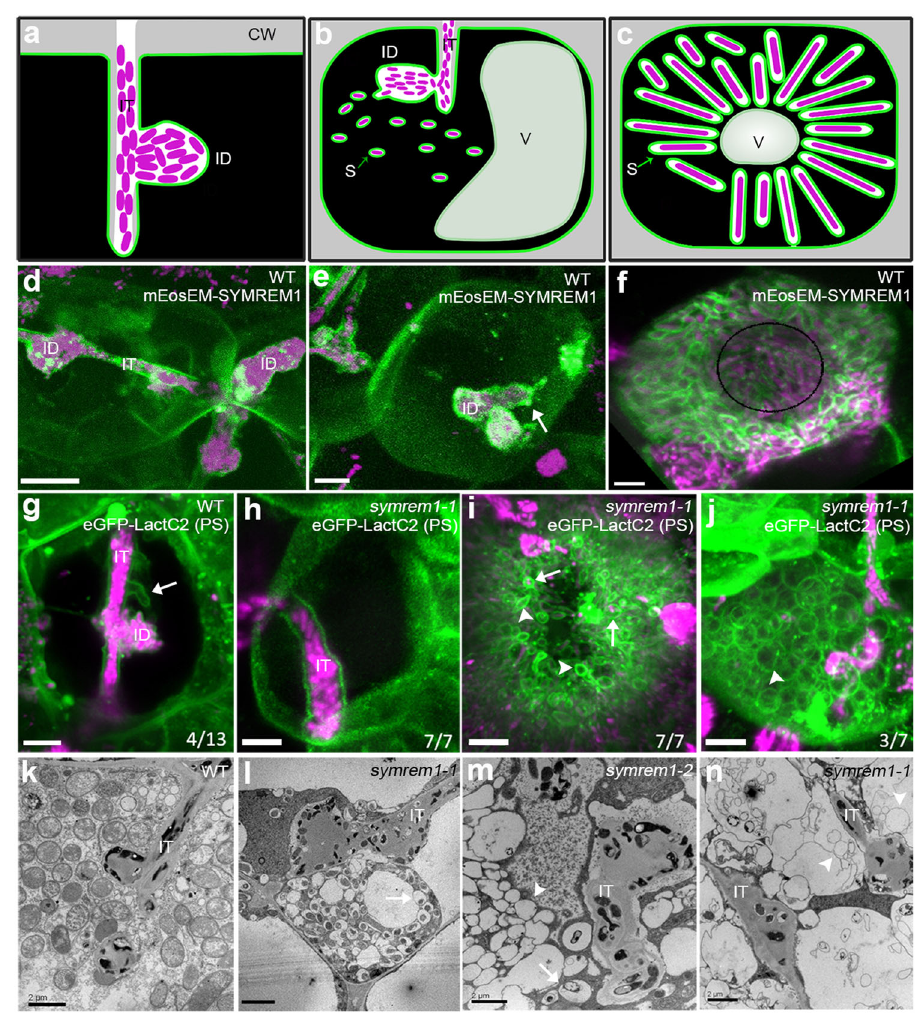
Fig. 1 | SYMREM1 stabilizes con fi ned membrane tubes during infection. a – c Illustrations indicate an infection thread (IT) with an infection droplet (ID; a ), symbiosome (S) formation ( b ) and a symbiosome- fi lled infected cell ( c ); CW cell wall, V vacuole. d – f Expression of a mEosEM-SYMREM1 fusion protein (green) speci fi cally labels IT membranes ( d ), accumulates at bacterial droplet structures (ID)( e ),andsymbiosomemembranes( f ). S.meliloti expressingamCherrymarkeris shown in magenta. The white arrow (in e ) indicates the bacterial release site; the black circle line (in f ) indicates the central vacuole. Single focal plane images for maximum projections of z-stacks ( d – f ) can be found in Supplementary Fig. 1. Experiments were performed with three biological replicates with at least 10 nodules being imaged per replicate. g – j Membranes werevisualizedby expressing